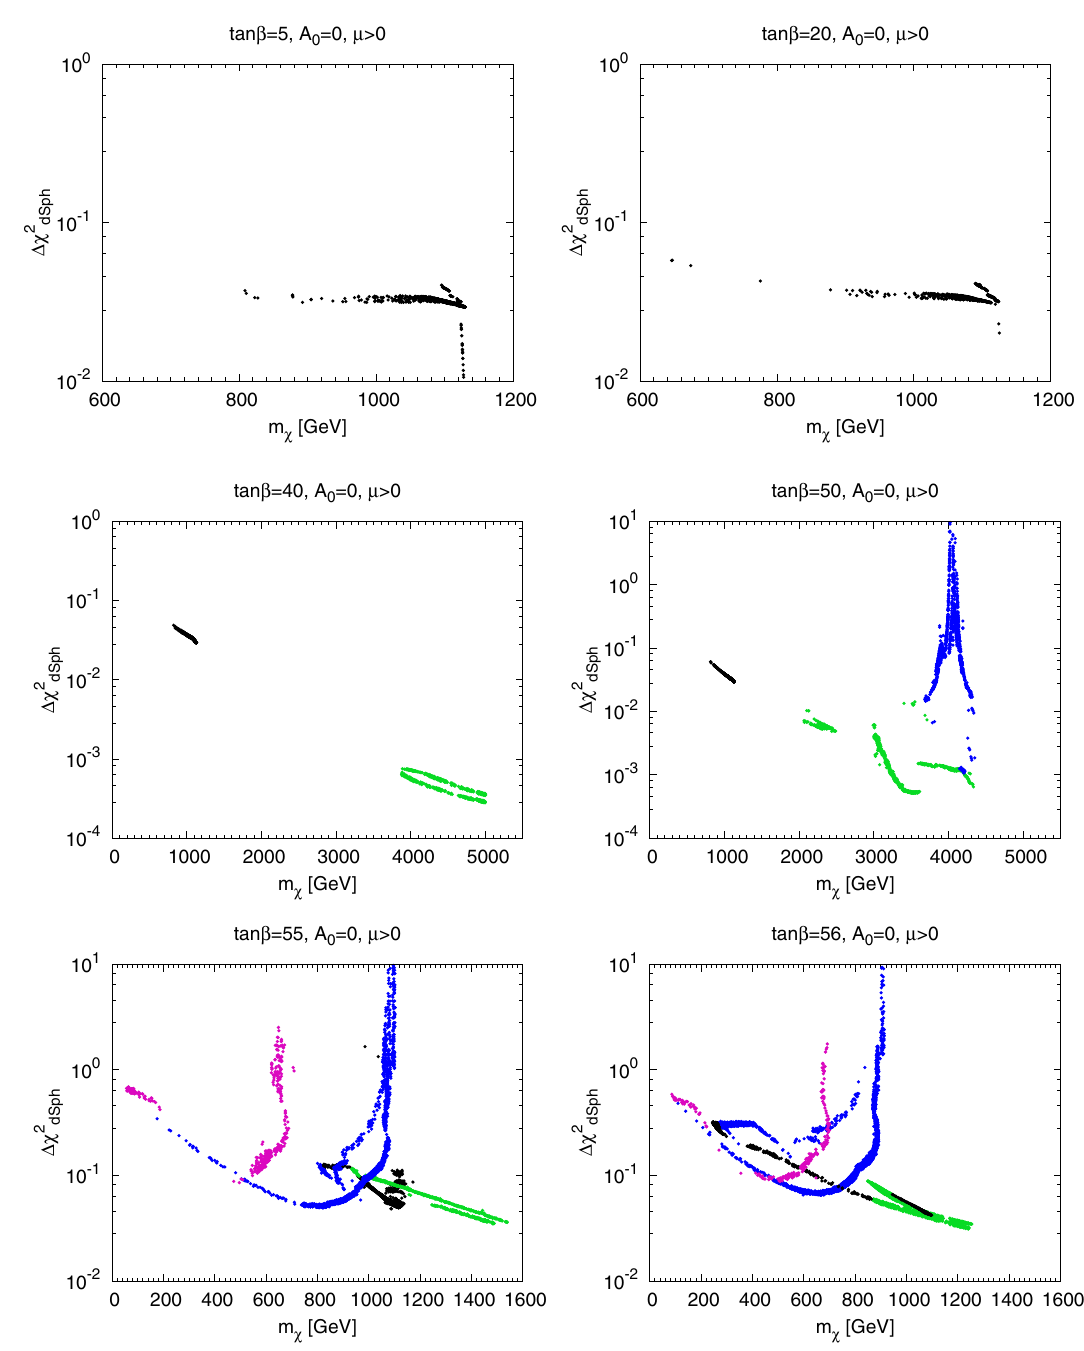
Fig. 11 Contributions to the global χ 2 likelihood function from a comparison of the Fermi -LAT upper limit on the flux of γ -rays from dwarf spheroidal satellite galaxies with calculations for points along the dark matter strips for tan β = 5 , 20 , 40 , 50 , 55 and 56 with A 0 = 0 and μ >